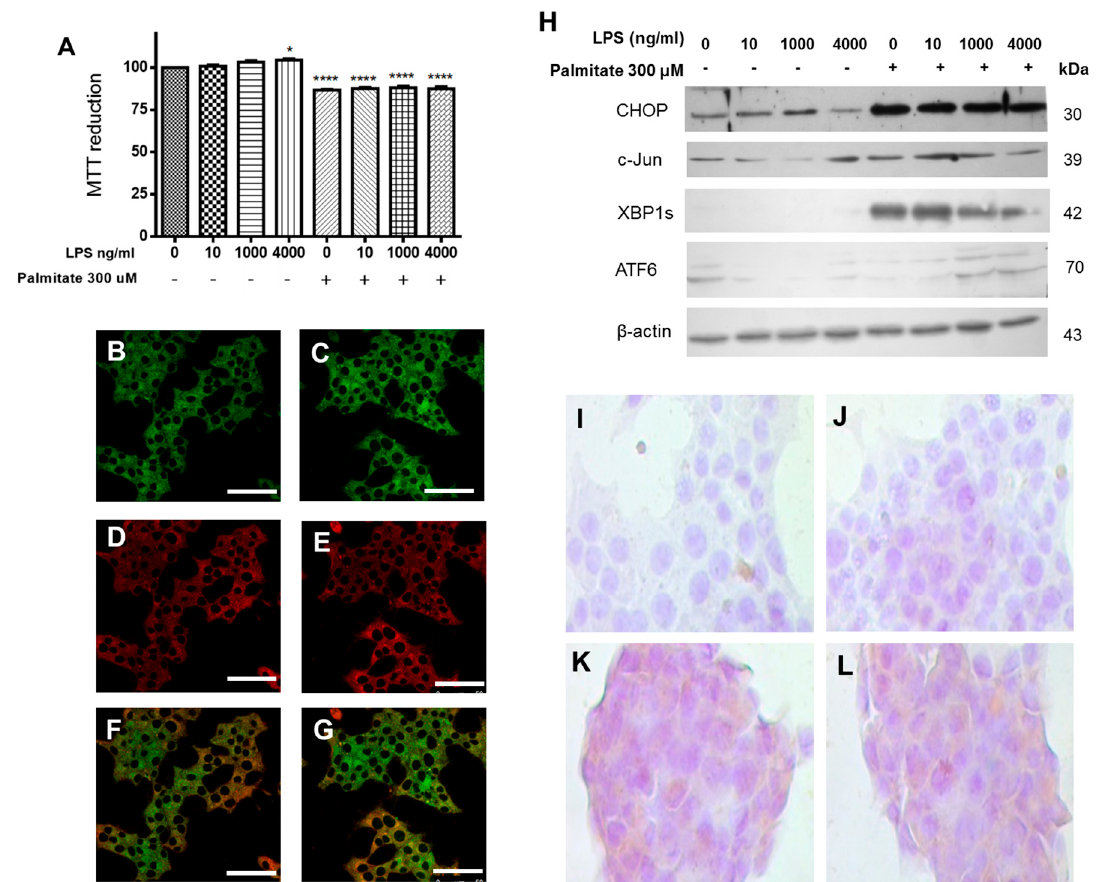
Figure 3. The combined treatment of LPS and PA potentiate the UPR activation in β -cells. ( A ) Effect of treatments with LPS and PA on cell viability ( n = 6, mean ± SD), * p < 0.05, **** p < 0.001. Confocal images of β -cells treated with BDP-PA ( B ), Aza-2-BDP ( D ) and the merge ( F ). Under the same conditions, β -cells treated with BDP-PA plus LPS ( C ), Aza-2-BDP plus LPS ( E ), and the merge ( G ). Bars correspond to 50 µm. ( H ) Expression of CHOP, c-Jun, XBP1s, and ATF6 α under increasing concentrations of LPS and PA (300 µM). β -actin was used as a loading control. ( I , J ) Detection of XBP1s by immunocytochemistry in control cells (negative signal). ( K , L ) Detection of XBP1s on PA-treated cells, positive signal (++) is determined by brown areas.